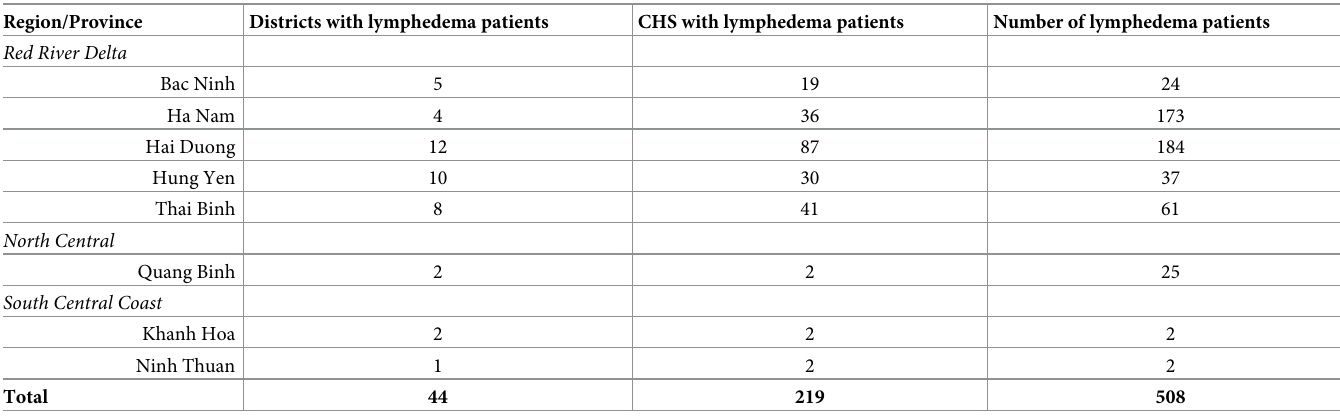
Table 2. Distribution of lymphedema patients by province � .